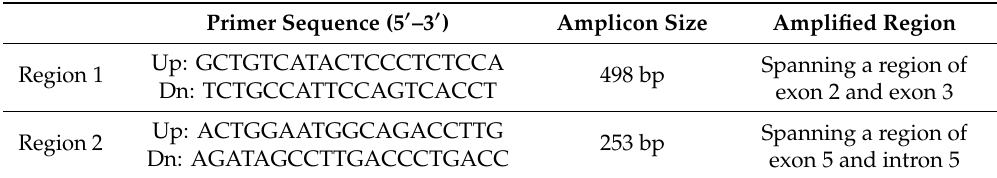
Table 2. The primer sequences for